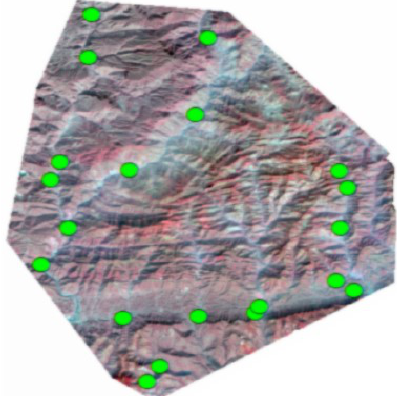
Figure 1.The route map of field check of District